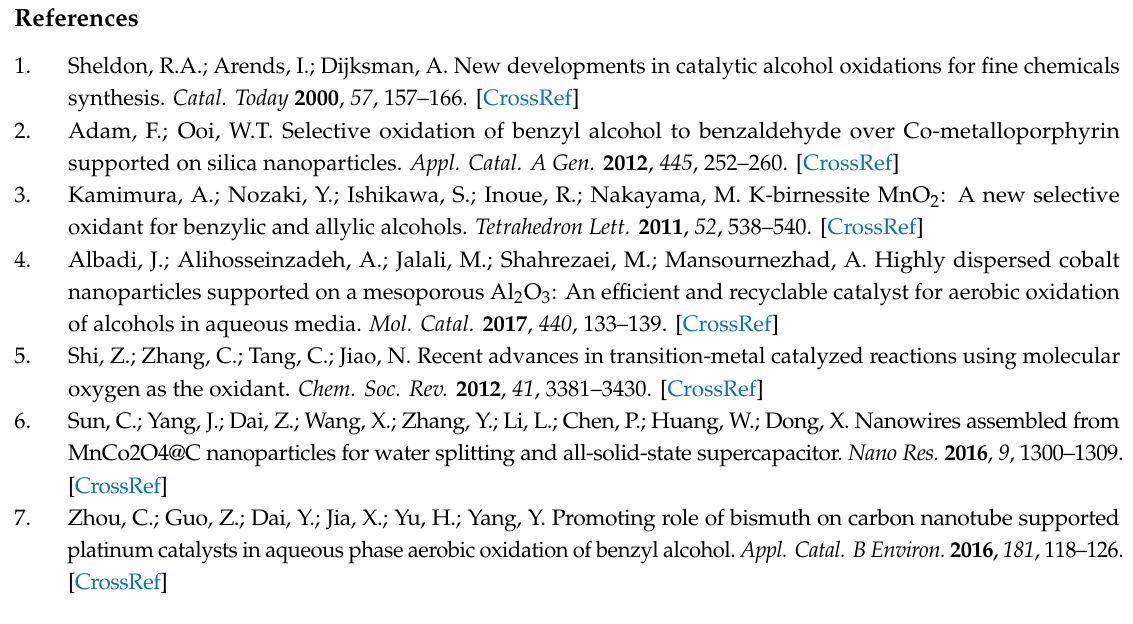
Figure S1: EDS analysis of synthesized catalysts (a) (1%)Co 3 O 4 –MnCO 3 and (b) (1%)Co 3 O 4 –Mn 2 O 3